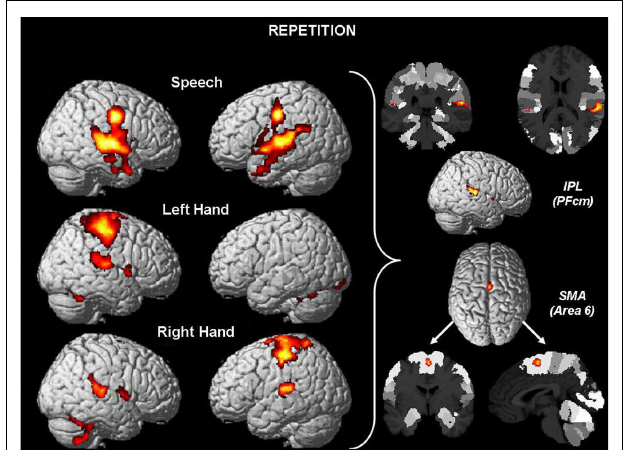
FIGUREA1 | Brain regions involved in repetition of events (three syllables, three button presses) more strongly than in single events (one button press, one syllable). Areas commonly involved in repetition in all three domains are area 6 in the supplementary motor area, and bilateral area PFcm in the supramarginal gyrus. For further details cf. the legend of Figure 1